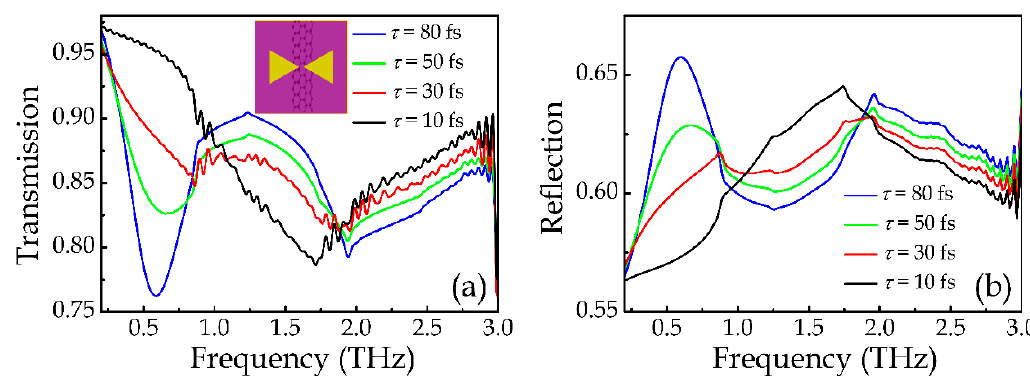
Figure 5. ( a ) Simulated transmission spectra of the DTDGS structure with g = 1 μ m under x -polarized incidences at different graphene scattering time τ from 80 to 10 fs, respectively. ( b ) Corresponding simulated reflection spectra of the DTDGS structure. The insets in ( a ) is the schematic of the corresponding structure.